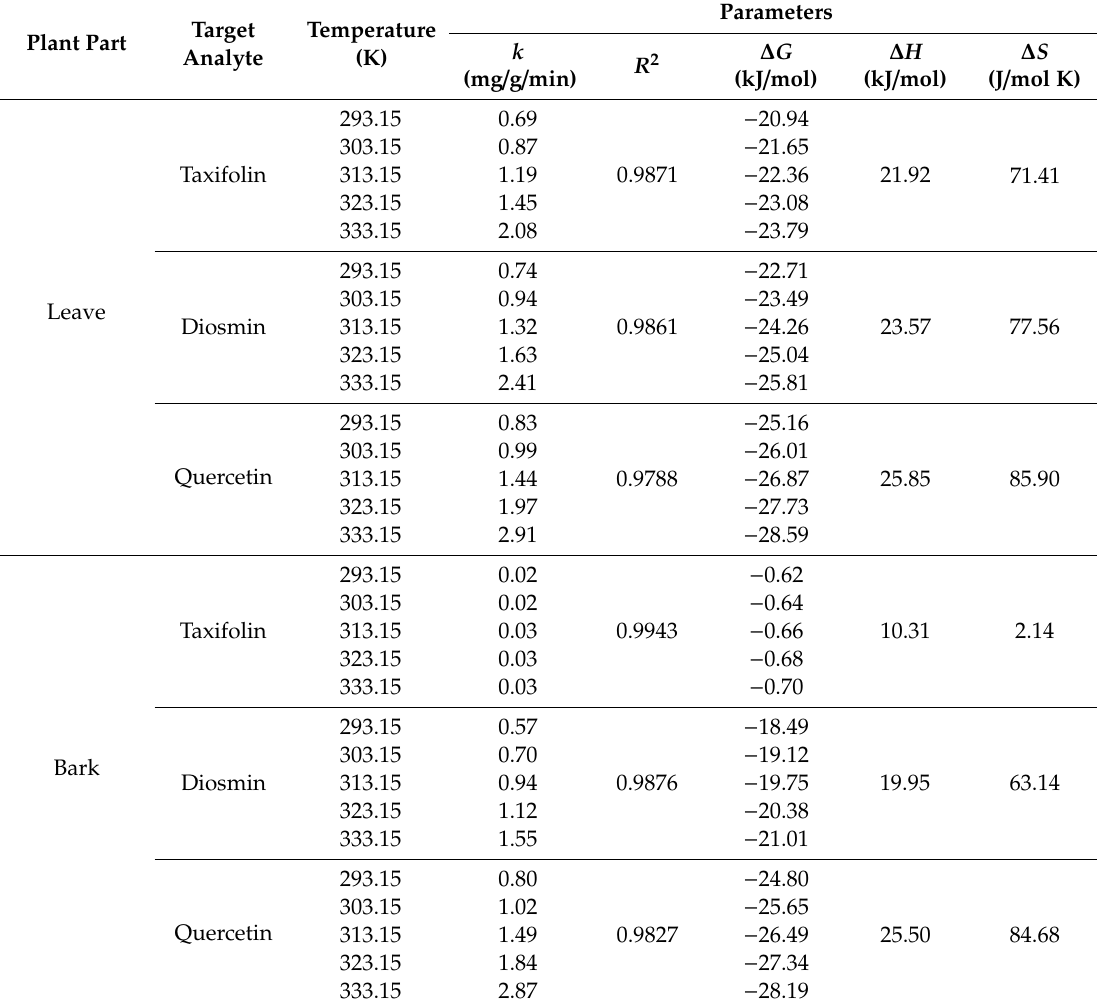
Table 1. Thermodynamic parameters of target flavonoids extracted from leaves and barks of A. nephrolepis .